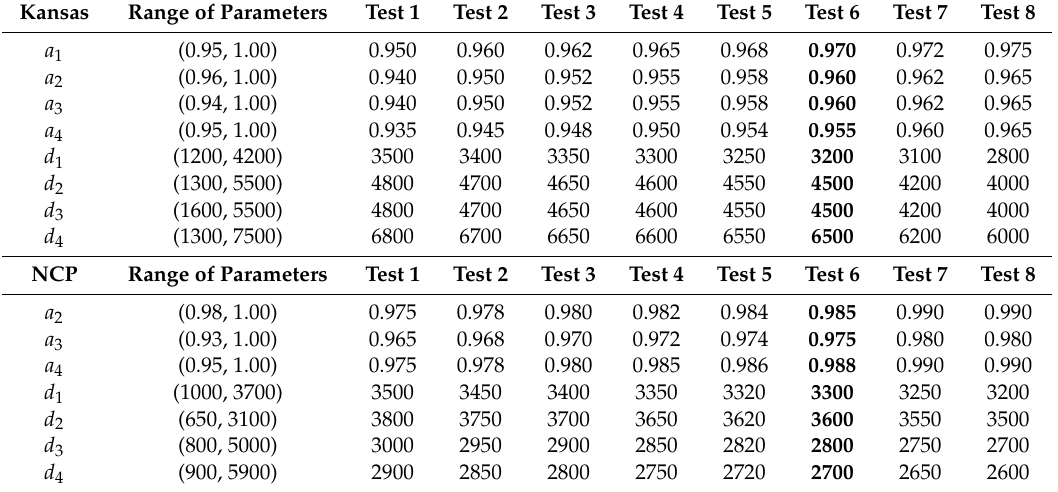
Table 5. The settings of thresholds of parameters for sensitivity study in two study areas 1 .